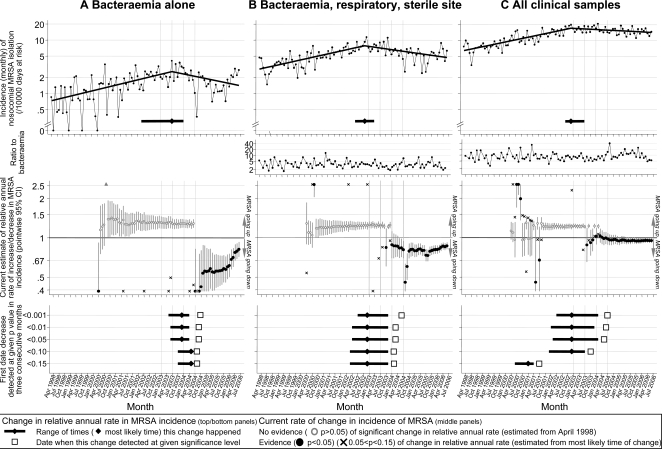
MRSA INCIDENCE OVER TIME.TOP PANELS: Monthly nosocomial MRSA incidence, and change in relative rates from blood cultures, the combination of bacteraemia, respiratory and sterile site samples, and all clinical samples. MIDDLE PANELS: estimates of relative annual rate of increase or decrease in incidence, calculated each month from April 2000 to June 2006. LOWER PANELS: the point at which changes in rate were most likely to have occurred, and when they could have been confidently detected by an infection control team monitoring trends.